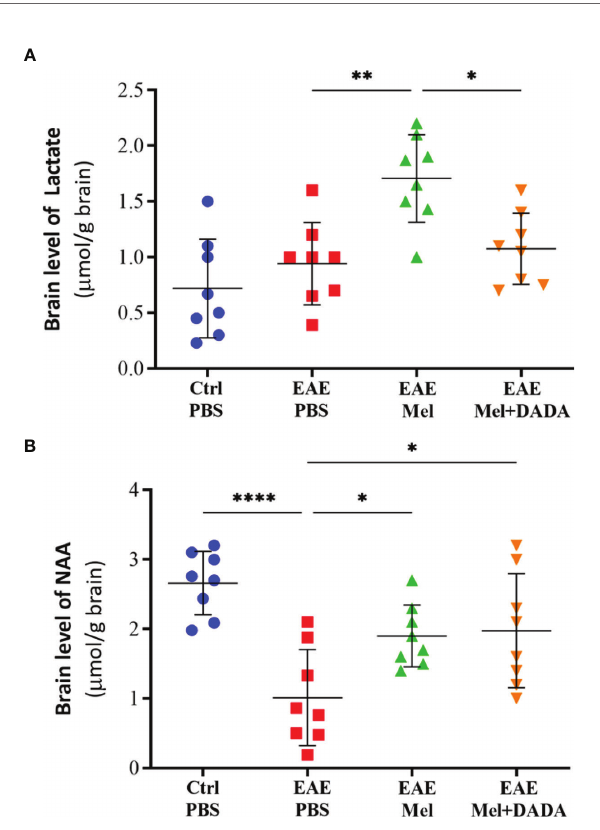
FIGURE 4 | Brain levels of (A) lactate and (B) N-acetylaspartate (NAA), using HPLC. Values are expressed as the Mean ± SEM. Each group included 8 mice (n = 8). Statistical analysis was performed by two-way analysis of variance (ANOVA) followed by Tukey ’ s test. Signi fi cance is indicated by *p < 0.05; **p < 0.01; and ****p < 0.0001.